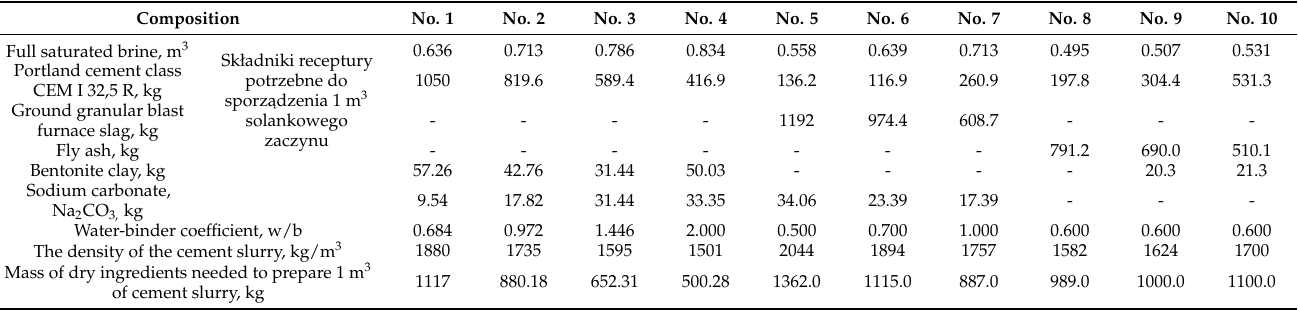
Table 1. Exemplary recipes of saline